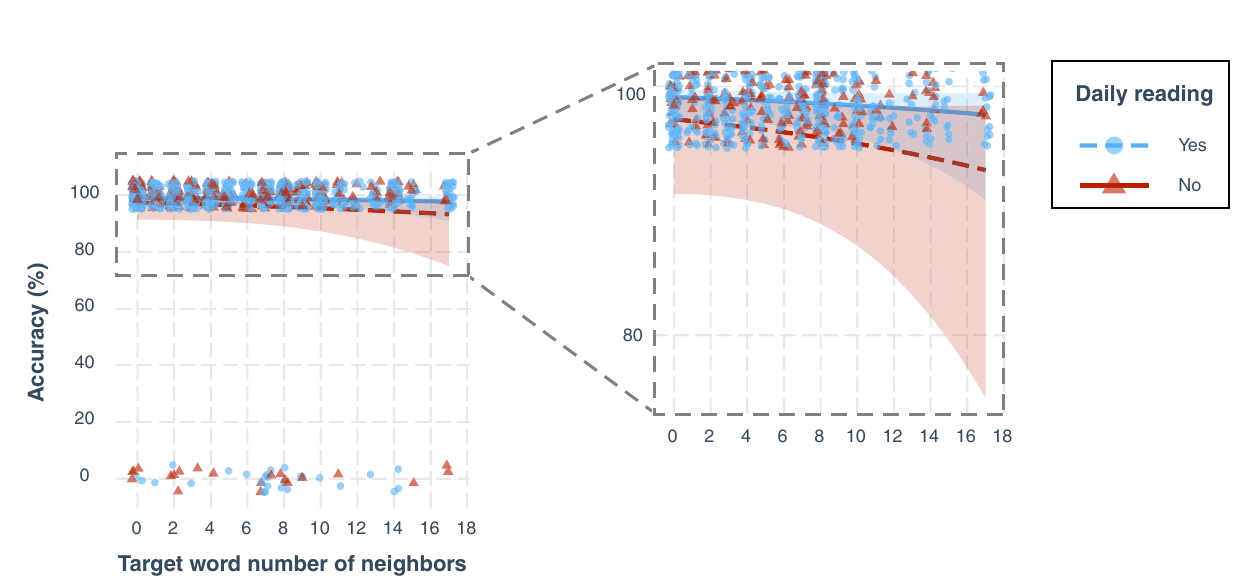
Figure 4. Effect of the neighborhood size (N) on word reading accuracy. Each data point represents a target word. Raw data points and fitted curves estimated by the GLME model are grouped according to reading proficiency: blue for participants reading daily, red for participants who quit daily reading activities. The right- side panel shows a zoomed view of the left plot between 70 and 100%